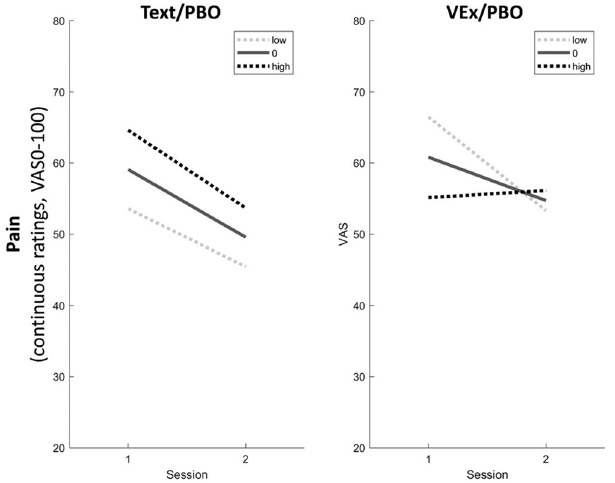
Figure 6. Moderation of the Delivery effect on pain by expectation of pain relief, controlling for desire for pain relief. In the Text Delivery (left panel), expectation has no effect (Session*Expectation p = 0.663, single contrast; the only conspicuous effects are due to baseline differences), whereas in the VEx Delivery (right panel), higher expectation was associated with lower pain improvement at retest (Session*Expectation p = 0.004, single contrast). Bright dotted line, low expectation of pain relief (− 1 standard deviation from group means); solid line, average expectation of pain relief; dark dotted line, high expectation of pain relief (+ 1 standard deviation from group